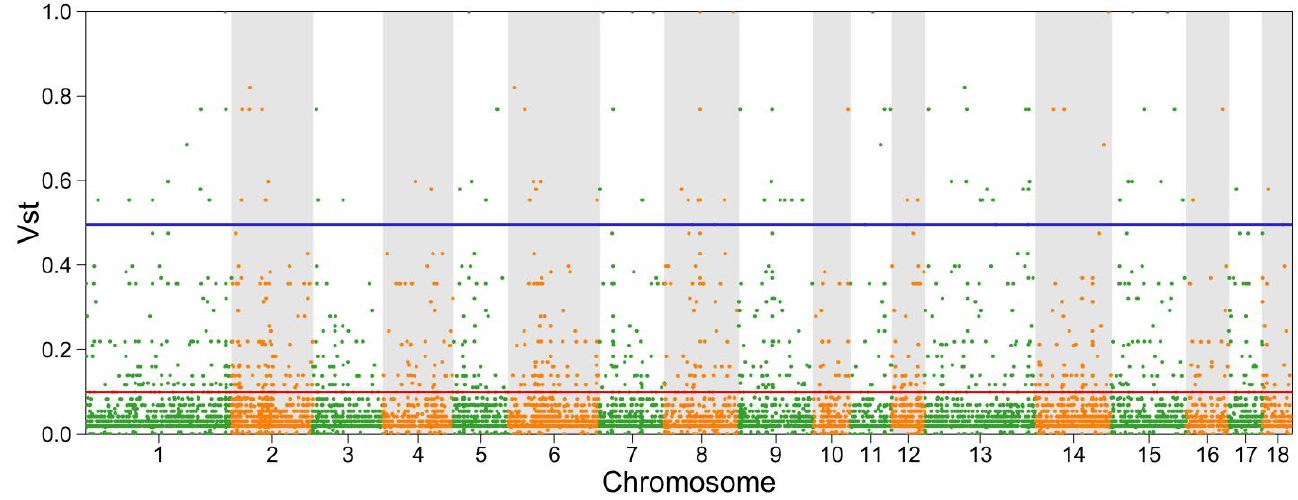
Figure 4. The V ST values distribution of copy number variation regions (CNVRs) in AQ and SS pigs among autosomal chromosomes. The red line and blue line represent the top 10% (V ST = 0.11) and top 1% (V ST = 0.55) levels. Points located above the blue line were identified as selected CNVRs for AQ pigs.